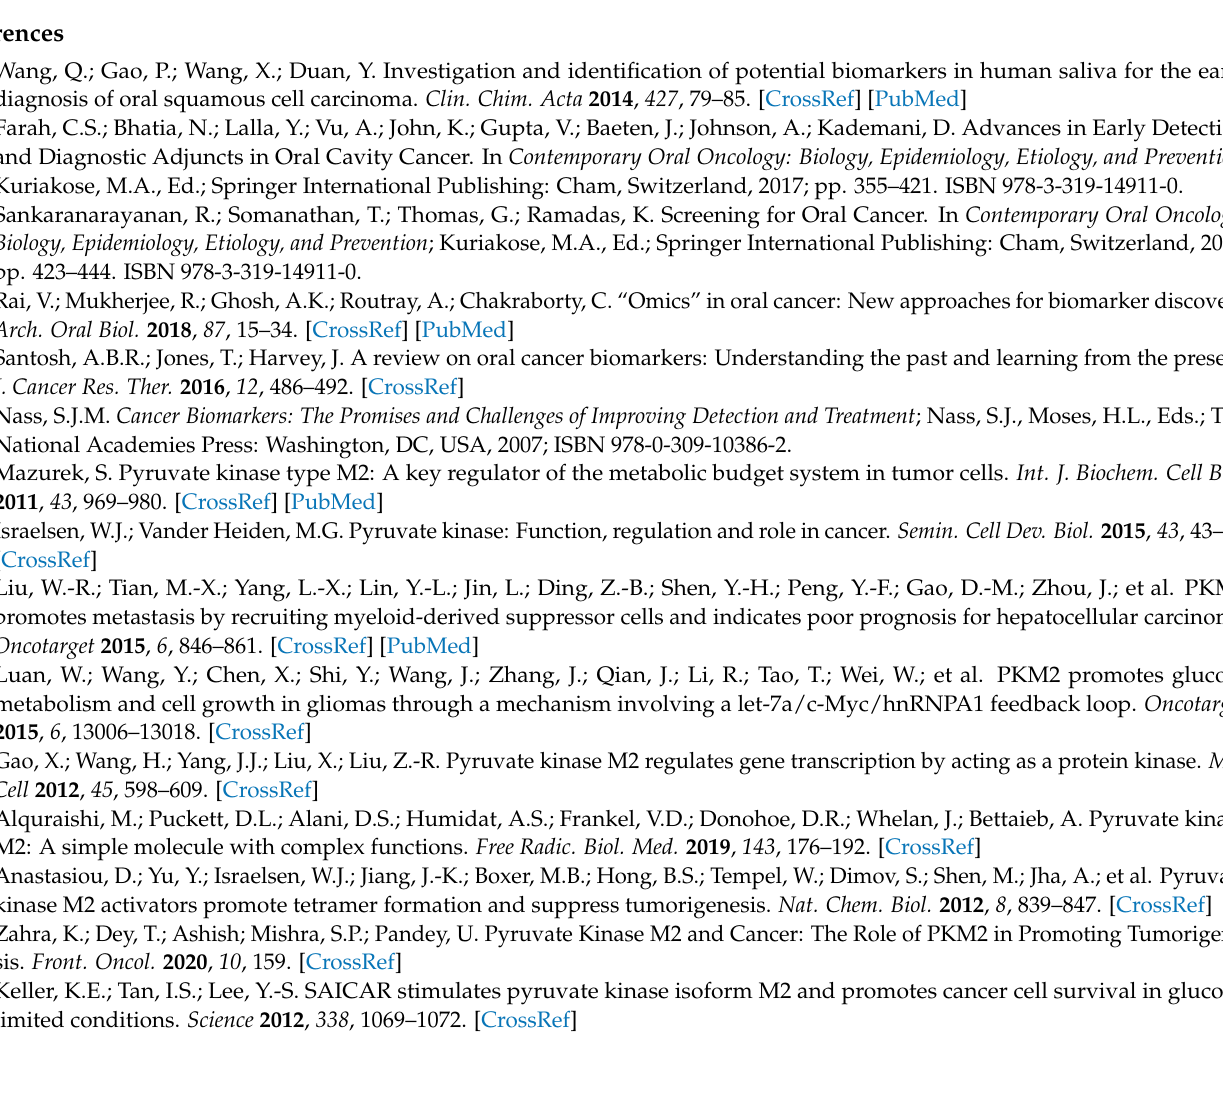
PKM2–SAICAR root mean square deviation (RMSD) plot for 10ns of time frame showing the stability of the complex between SAICAR depicts strong and specific binding to PKM2. Figure 4. SAICAR shows specific contacts within the activation site of PKM2. (A) PKM2 and SAICAR interaction plot on the interaction between amino acid residues and ligand remained during 10ns simulation. On the Y-axis, the interaction fraction shows the time of established interaction between key amino acid and ligand through different types of bonds such as hydrogen bonds, hydrophobic, ionic, and water bridges. (B) Schematic diagram on the interaction of the ligand with amino acid residues, which has remained for more than 30% of interaction time of the simulation. Here, various color combinations are used to represent the extent and nature of ligands to enzyme atomic interactions including ionic, hydrophobic, polar, water, and solvent exposure. Figure 5. Webserver to predict absorption, distribution, metabolism, excretion, and toxicity (vNN-ADMET) predicts SAICAR as a substrate of drug transporter P-gp and no adverse cell toxicity. Figure 6. A proposed model on the role of SAICAR oncometabolite as a nail metabolite biomarker and predicted as a key metabolite in growth and proliferation by binding to PKM2. Figure S1. A model on a novel vertical tube gel electrophoresis (VTGE) system. (A) A flow diagram of VTGE system. (B) A running model on VTGE